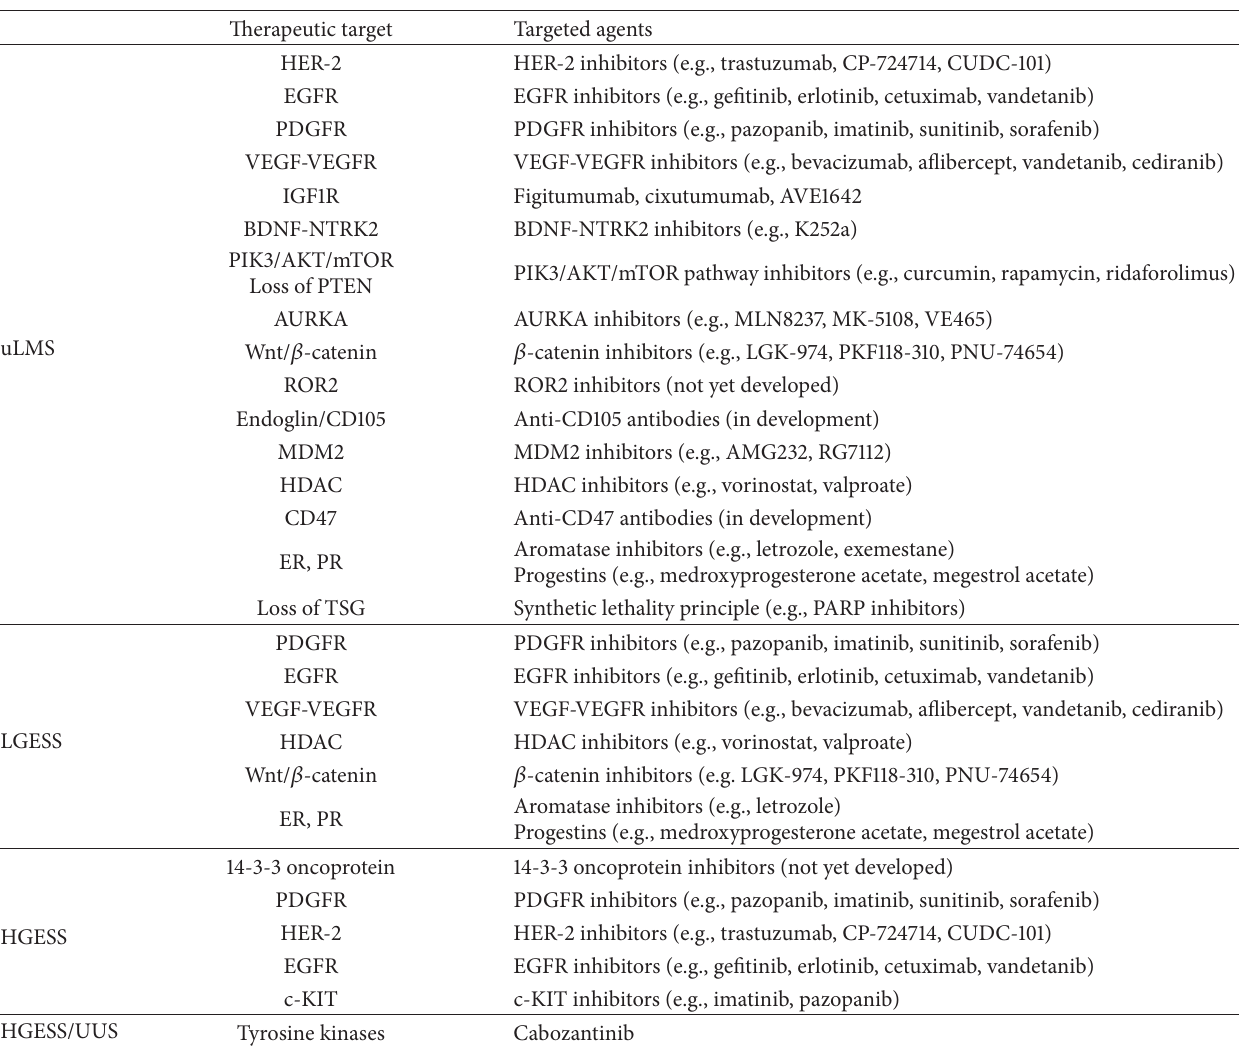
Table 1: Overview of potential therapeutic targets and corresponding treatments in uterine